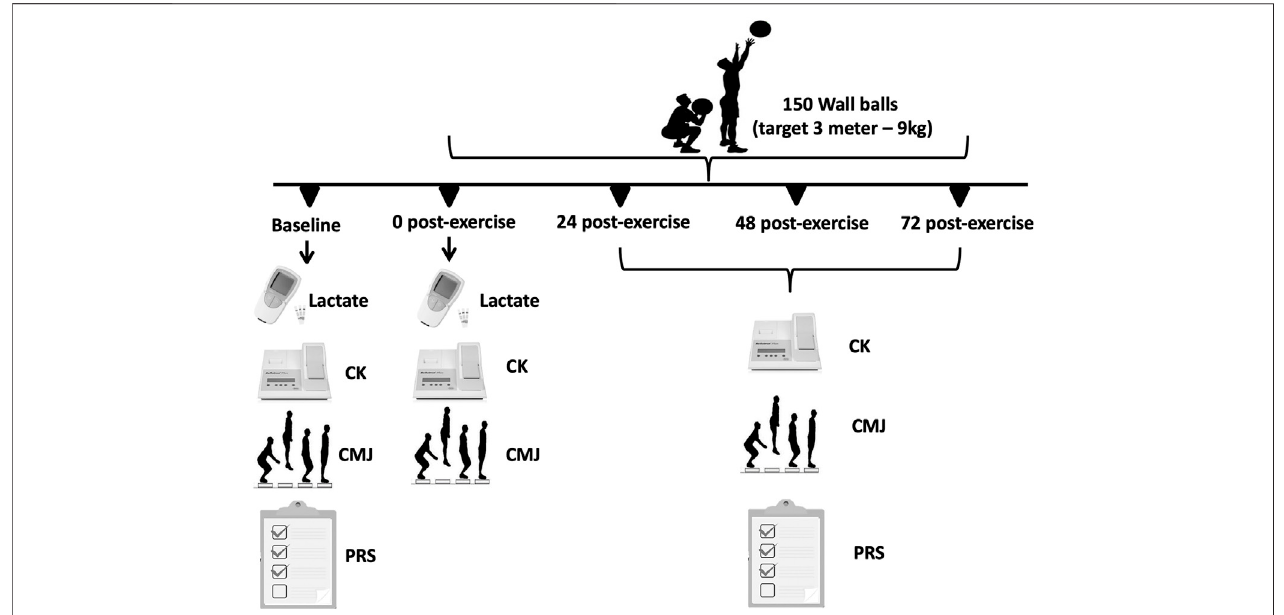
FIGURE 1 | Schematic study design and timeline used to examine the time-course effects of creatine kinase, countermovement jump performance and the PRS scale.